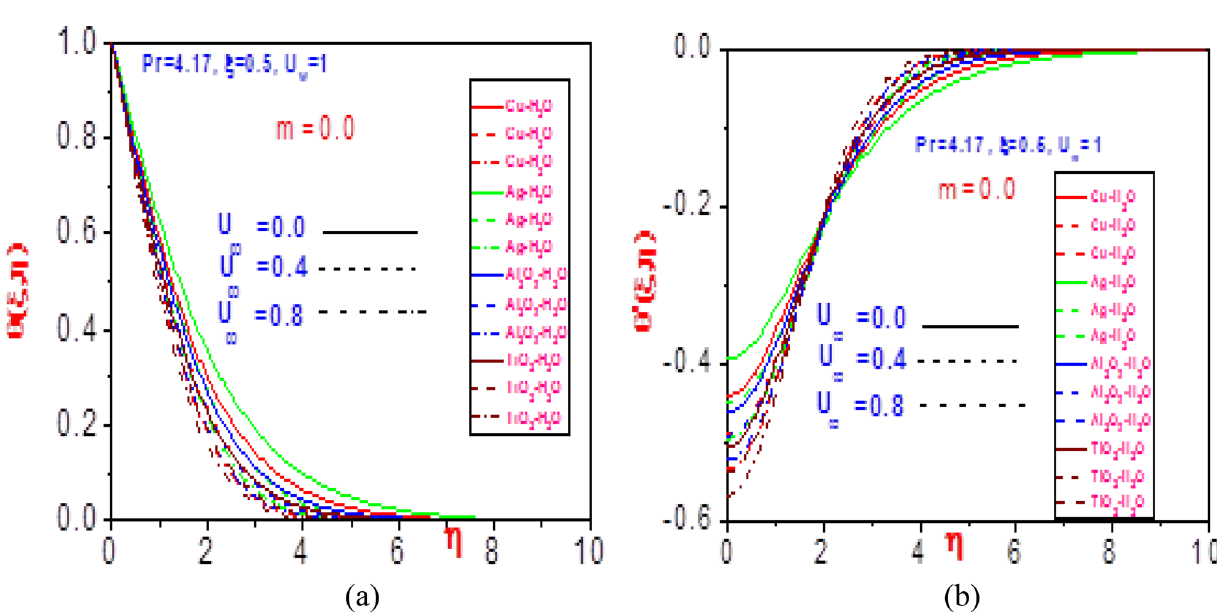
Figure 14. Profiles of ( a ) temperature θ(ξ , η) , ( b ) missing temperature slope θ ′ (ξ , η) with different values of U ∞ and m = 0 for Cu-H 2 O, Ag-H 2 O, Al 2 O 3 -H 2 O and TiO 2 -H 2